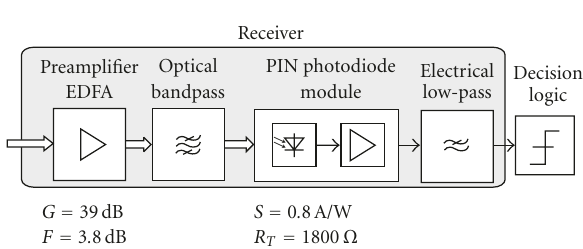
Figure 1: Setup of an optically preamplified receiver ( G : preampli- fier gain, F : preamplifier noise figure, S : photodiode responsivity, R T : transimpedance).